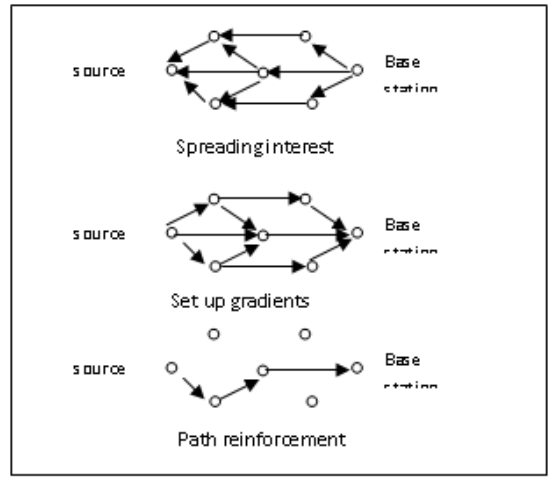
Figure 6. Directed Diffusion